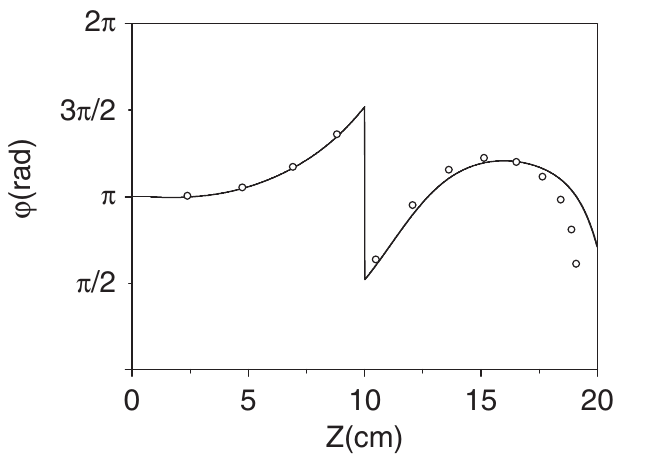
FIG. 8. Electron energy evolution at different initial injection ¼ 10 keV , energies for a parabolic magnetic field case: (A) W i ¼ 20 keV , (C) W ¼ 30 keV . (B) W i i